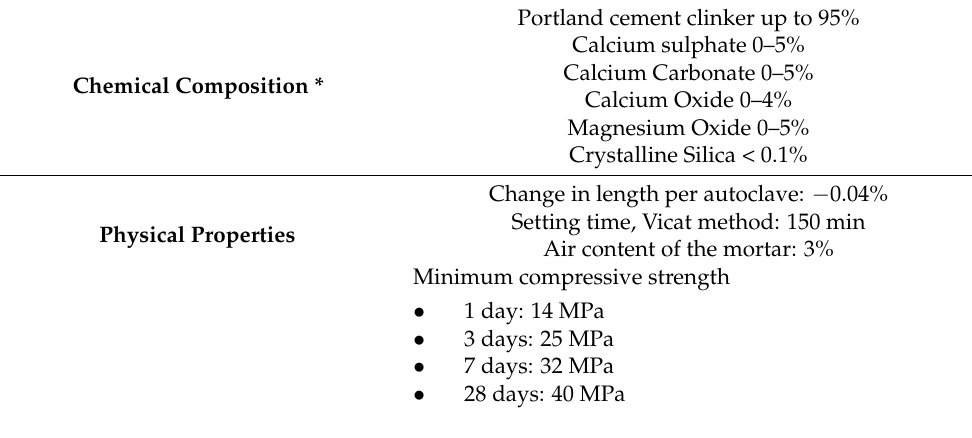
Chemical Composition